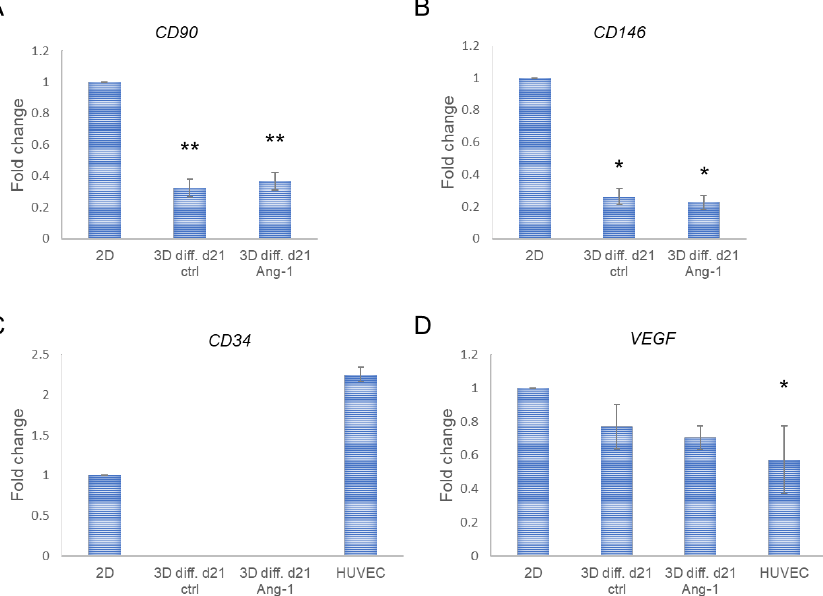
Figure 6. Quantitative real-time PCR of differentiated hASCs. ( A – C ) Relative expression of cell surface antigens CD90 ( A ), CD146 ( B ), and CD34 ( C ). ( D ) Relative expression of VEGF . * p < 0.05, ** p < 0.01 vs. 2D. N = 2–3 (3 technical